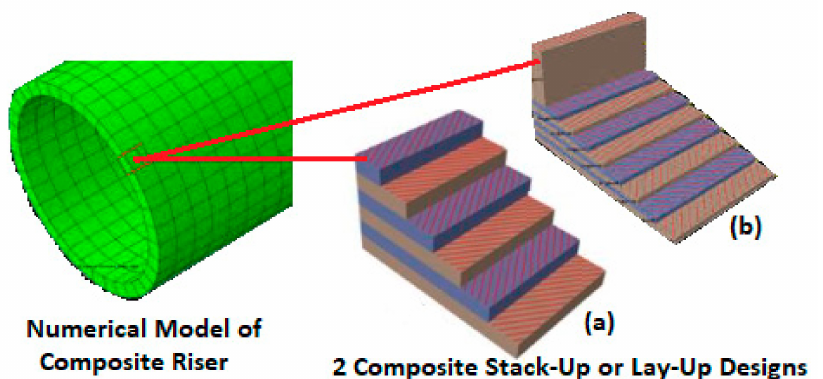
Figure 11. Typical composite riser structure showing ( a ) tubular structure and ( b ) the layers with two different lay-up